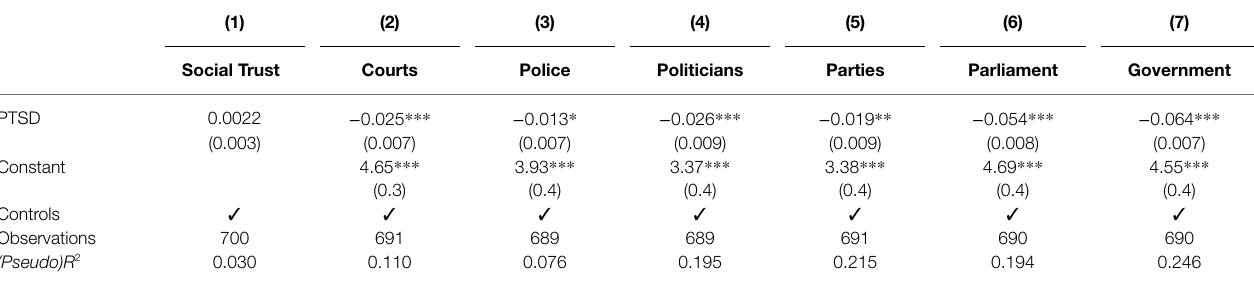
TABLE 7 | The impact of symptoms of posttraumatic stress on